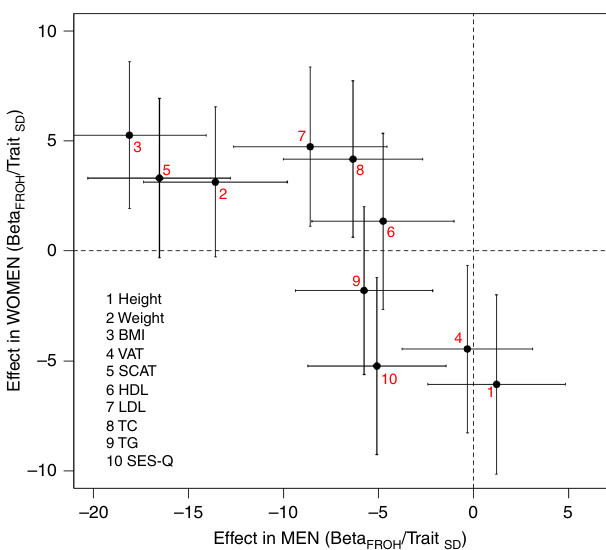
Fig. 3 Sex-speci fi c inbreeding depression. As in the previous fi gure effects estimates and coef fi cients were standardized using within-sex standard deviations. Effects estimates ( β FROH ) and 95% con fi dence intervals are shown in units of within-sex standard deviations. The effect of F ROH in men versus that in women is shown for 9 traits for which there was evidence of signi fi cant differences in the effects between sexes. Traits such as body mass index (BMI), subcutaneous adipose tissue (SCAT), low density lipoprotein cholesterol (LDL) and total cholesterol (TC) showed sex- speci fi c effects of opposite direction, positive in women but negative in men. For just two traits, visceral adipose tissue (VAT) and height, the magnitude of effect was greater in cultural bias in SES measurement and other differences among populations, we used the quintiles of the SES variable (SES.Q)